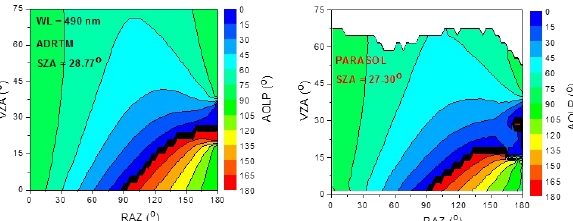
Figure 4. Comparison of the modeled AOLP of desert-reflected so- lar light with those from the PARASOL data at the wavelength of 490nm. The SZA is 28.77 ◦ in the modeling. The SZA is in the bin of 27–30 ◦ for the PARASOL data.